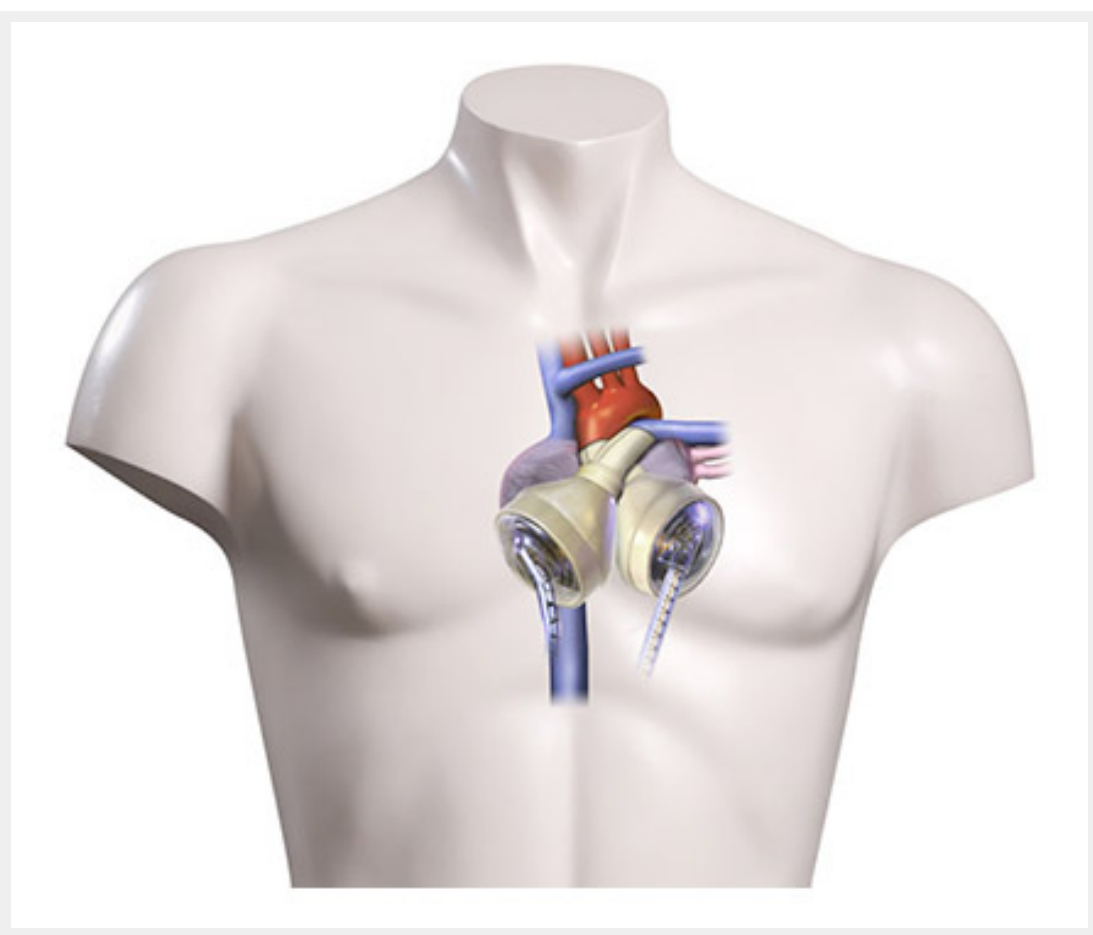
Figure 5 The Cardiowest is a Total Artificial Heart provided by Snycardia (Tucson, AZ, USA). (http://www.syncardia.com/Medical-Professionals/compare-